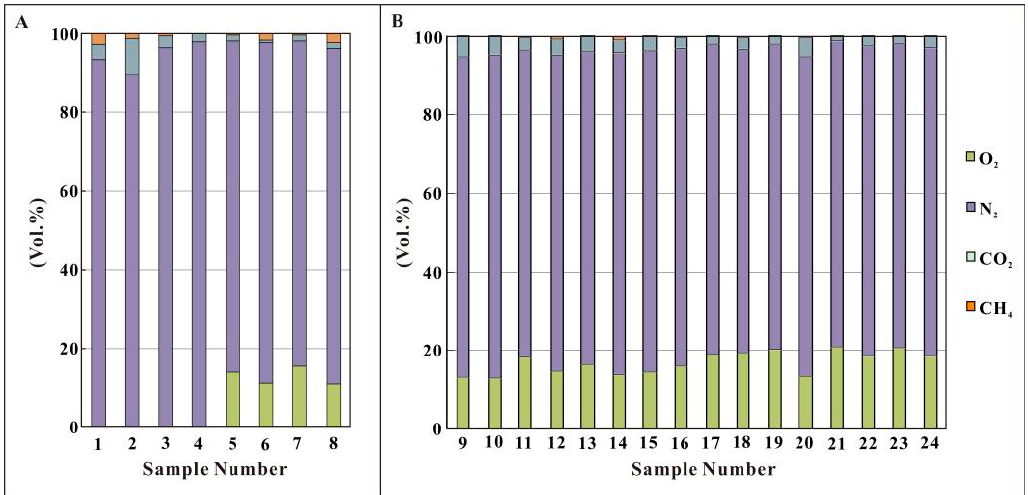
Figure 2. Results of gas composition analysis: ( A ) Niutitang Formation gas samples from the Youye-1 well; ( B ) Wangyinpu and Guanyintang Formations gas samples from the Jiangye-1 well. The gas sample information can be seen in Table 1.